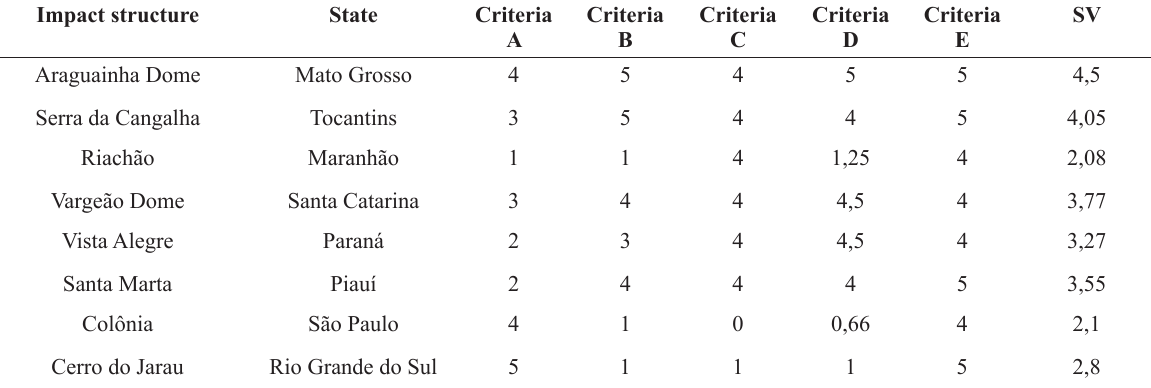
scientifi c value (sv) of the eight impact structures in Brazil and evaluation results for the fi ve criteria (also rep resented in fi gures 2 and 3).